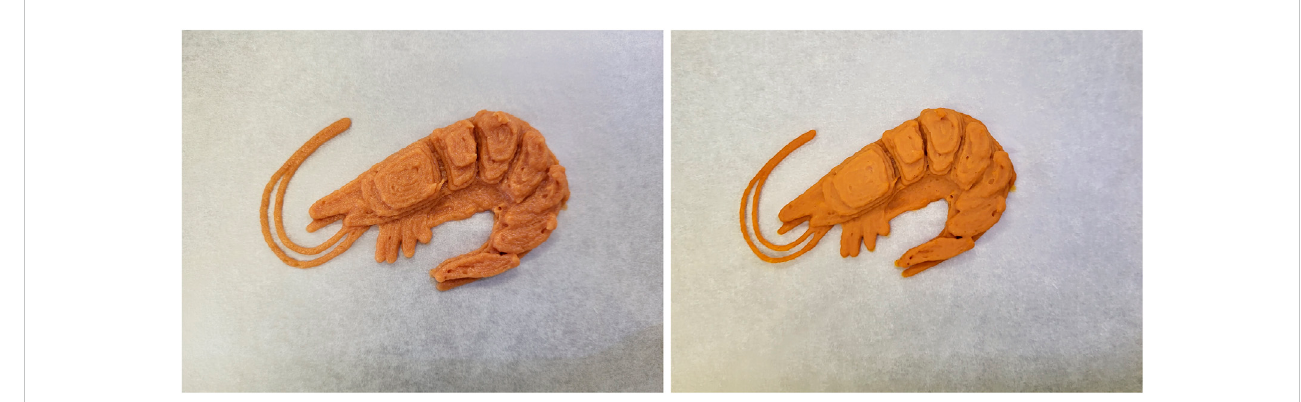
FIGURE 5 3D printed Shrimp of the forumulation with 3 wt% citrus fi ber and 3.5 wt% starch shown before (left) and after (right) baking. The shrimp design was selected from the internal libray of the Foodini and printed with the ingrient mousse-cream and is approximatly 5 cm in length.